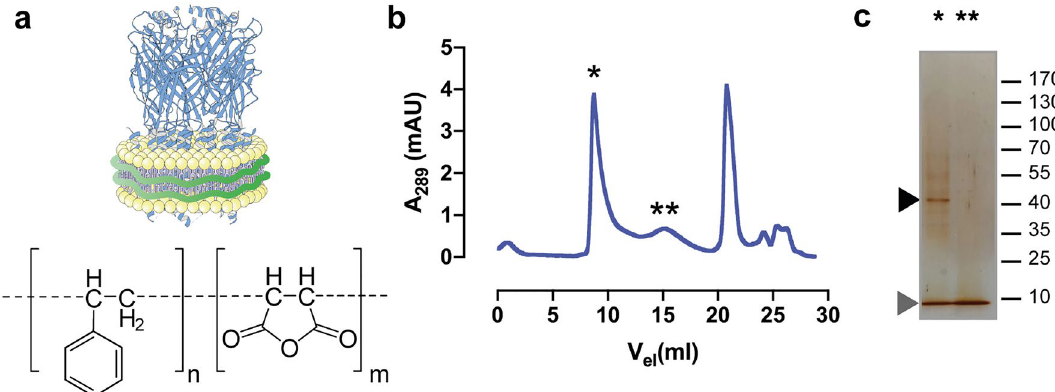
Figure 1. Purification and functional characterization of the α1-His GlyR in SMA-copolymer nanodiscs. ( a ) Schematic representation of GlyR (PDB: 3JAE) in native nanodiscs (upper) and chemical structure of SMA- copolymer (lower) with a ratio of n:m of 2:1 used in this study. Size exclusion chromatogram ( b ) and SDS-PAGE analysis ( c ) showing an efficient separation of α1-His GlyR nanodiscs. Peak fraction (*) shows a clear band (black arrow) between 40 and 55 kDa, corresponding to the α1 GlyR (MW: 48 kDa) and a band migrating at ~ 10 kDa corresponding to SMA copolymer. Gel image was cropped, indicated by a grey cropping line. Subfigure ( a ) was created using Abobe Illustrator CC version 24.3 (https ://www.adobe .com/kr/produ cts/illus trato